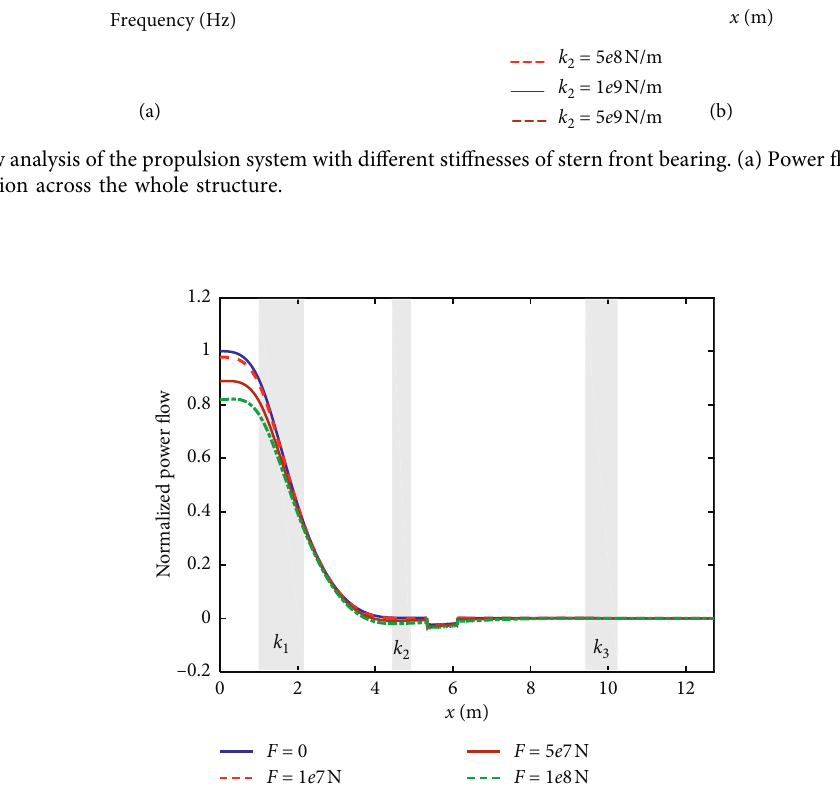
Figure 10: Power flow analysis of propulsion shafting system with different thrust